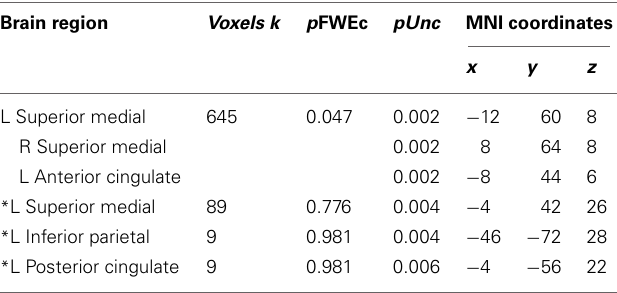
FIGURE 5 | Salience and default mode network BOLD responses to Aware > Unaware Errors. During conscious error monitoring we observed significant activations throughout the salience and control networks, including mid-cingulate ( top right ), middle frontal, dorsolateral prefrontal, bilateral caudate ( bottom right ), right insula ( bottom right ), superior, and inferior parietal cortex ( bottom left ) activations. Note that in addition to common salience and error related regions, we observed bilateral inferior parietal responses to this contrast, i.e., co-activation of salience and DMN. Statistical parametric map (pFWE < 0.05, k threshold > 5 contiguous voxels) superimposed on SPM canonical anatomical image, average of 305 T1-weighted images. Top left “glass brain” displays activation extent in three dimensional space. Top right shown at MNI X coordinate = 1, bottom left at X = − 43. Bottom right shown at Z = 1. See Table 5 for a complete list of foci. Table 6 | Regions showing correlations between task-related BOLD and TUT